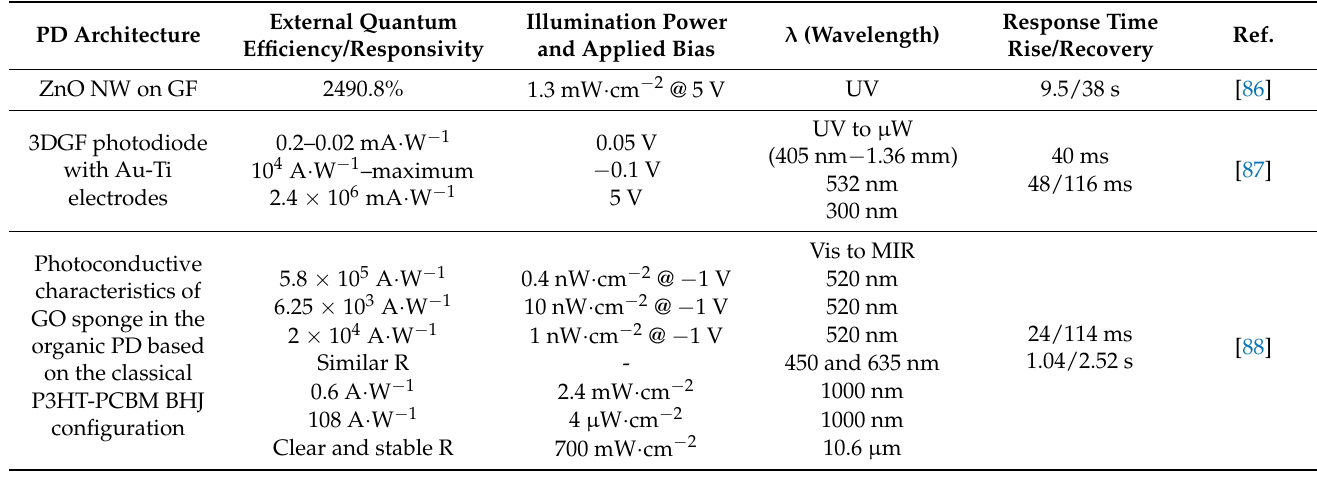
Table 6. The performance of photodetectors based on 3D graphene networks.